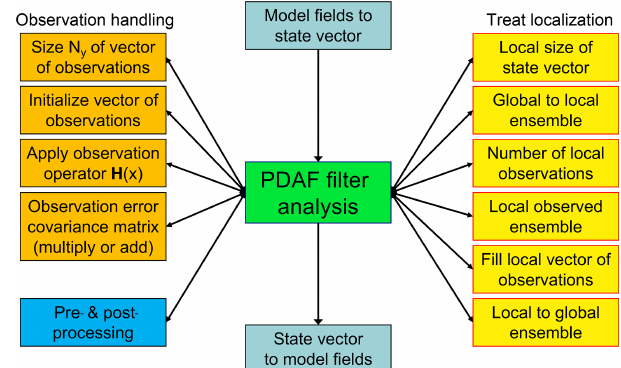
Figure 4. PDAF filter analysis step and related call-back routines provided by the user. There are four types of routines: transfers be- tween model fields and state vector (cyan), observation handling (orange), treatment of localization (yellow), and pre- and postpro- cessing